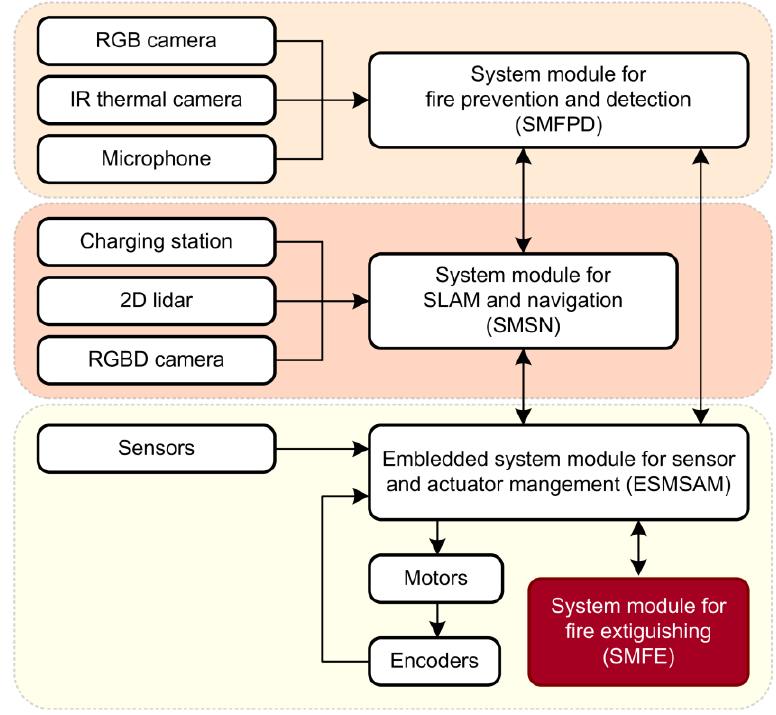
Figure 2. The proposed FireBot system-architecture diagram.